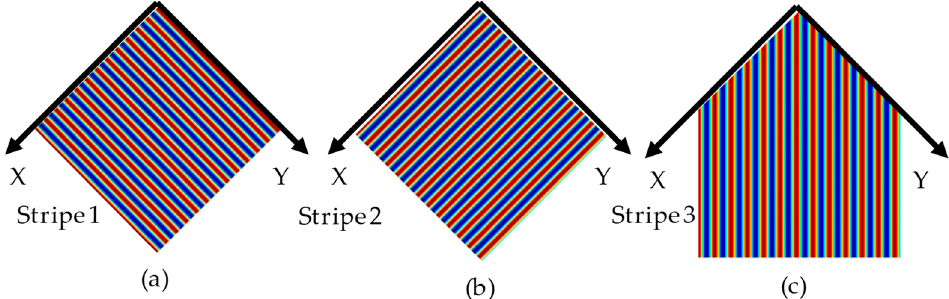
Figure 4. Interference fringe patterns generated by two of beam 1, 2, and 3. ( a ) beams 1 and 2; ( b ) beams 1 and 3; and ( c ) beams 2 and 3.